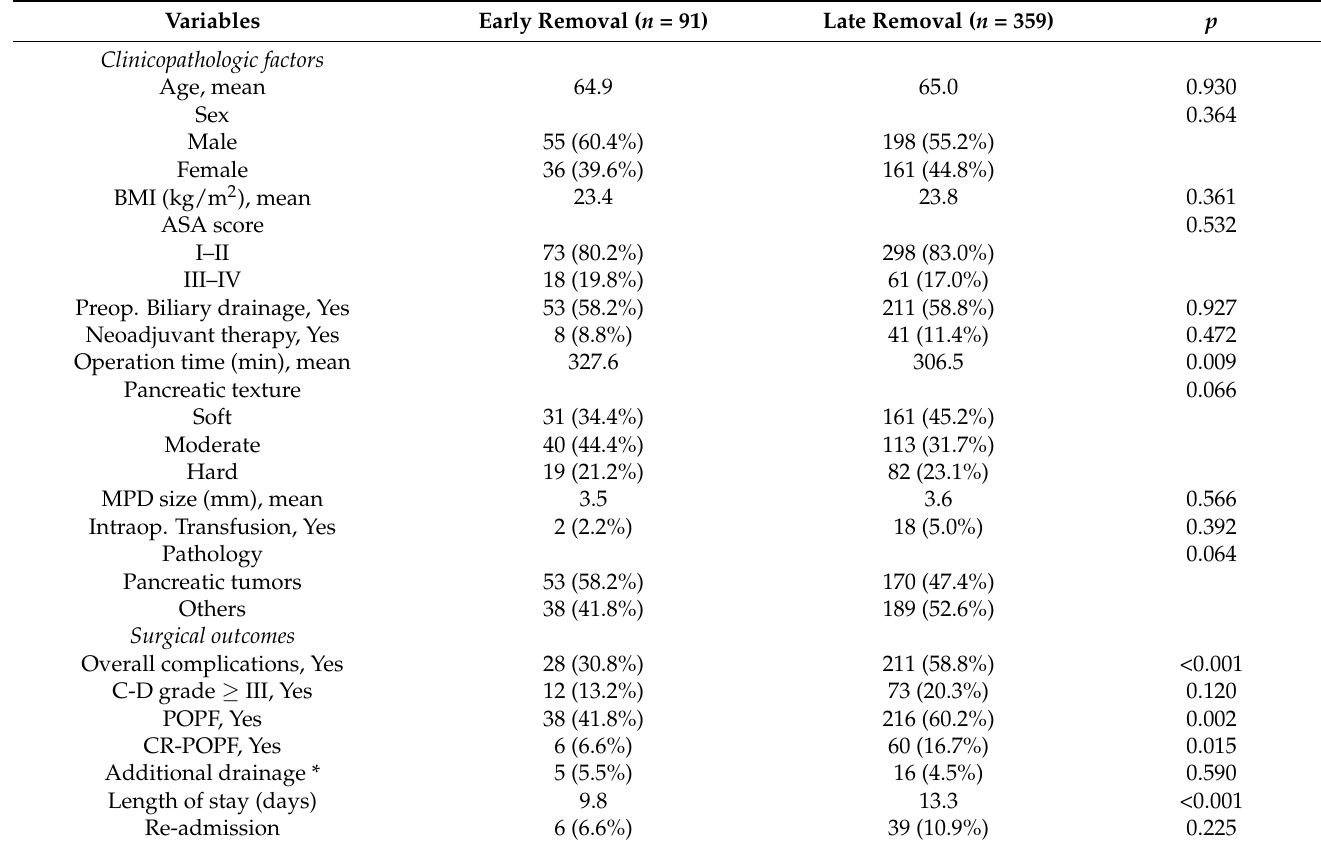
Table 2. Comparison of the early removal group and the late removal group in all patients ( n =